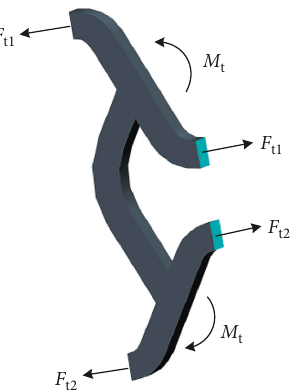
Figure 14: Diagram of force analysis of the c-shaped bridge during